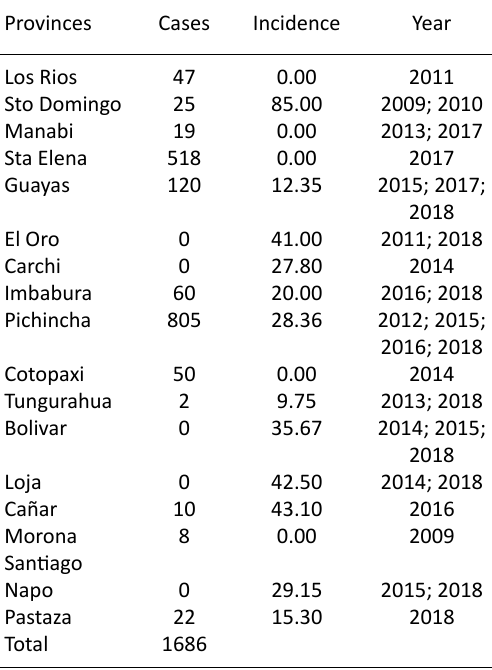
Table 4. Cases and Incidence of Salmonella genus for provinces in Ecuador